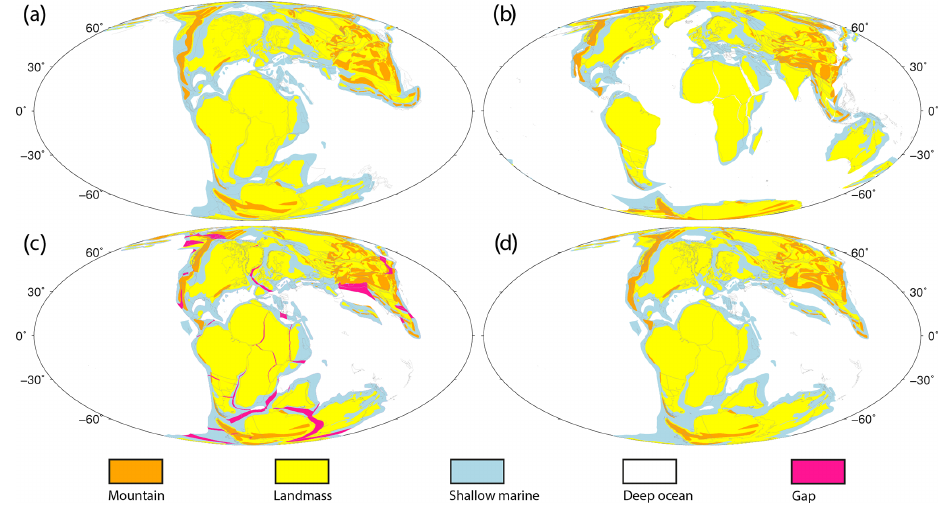
Figure 3. (a) Original global paleogeographic map from Golonka et al. (2006) at 126Ma. (b) Global paleogeographic geometries at 126Ma in present-day coordinates. (c) Global paleogeography at 126Ma reconstructed using the plate motion model of Matthews et al. (2016). Gaps are highlighted in pink. (d) Global paleogeography at 126Ma reconstructed using the reconstruction of Matthews et al. (2016) with gaps fixed by filling with adjacent paleoenvironment attributes. Grey lines indicate reconstructed present-day coastlines and terrane boundaries. Mollweide projection with 0 ◦ E central meridian. Table 2. Lookup table to classify fossil data indicating different paleoenvironments into marine or terrestrial settings and their